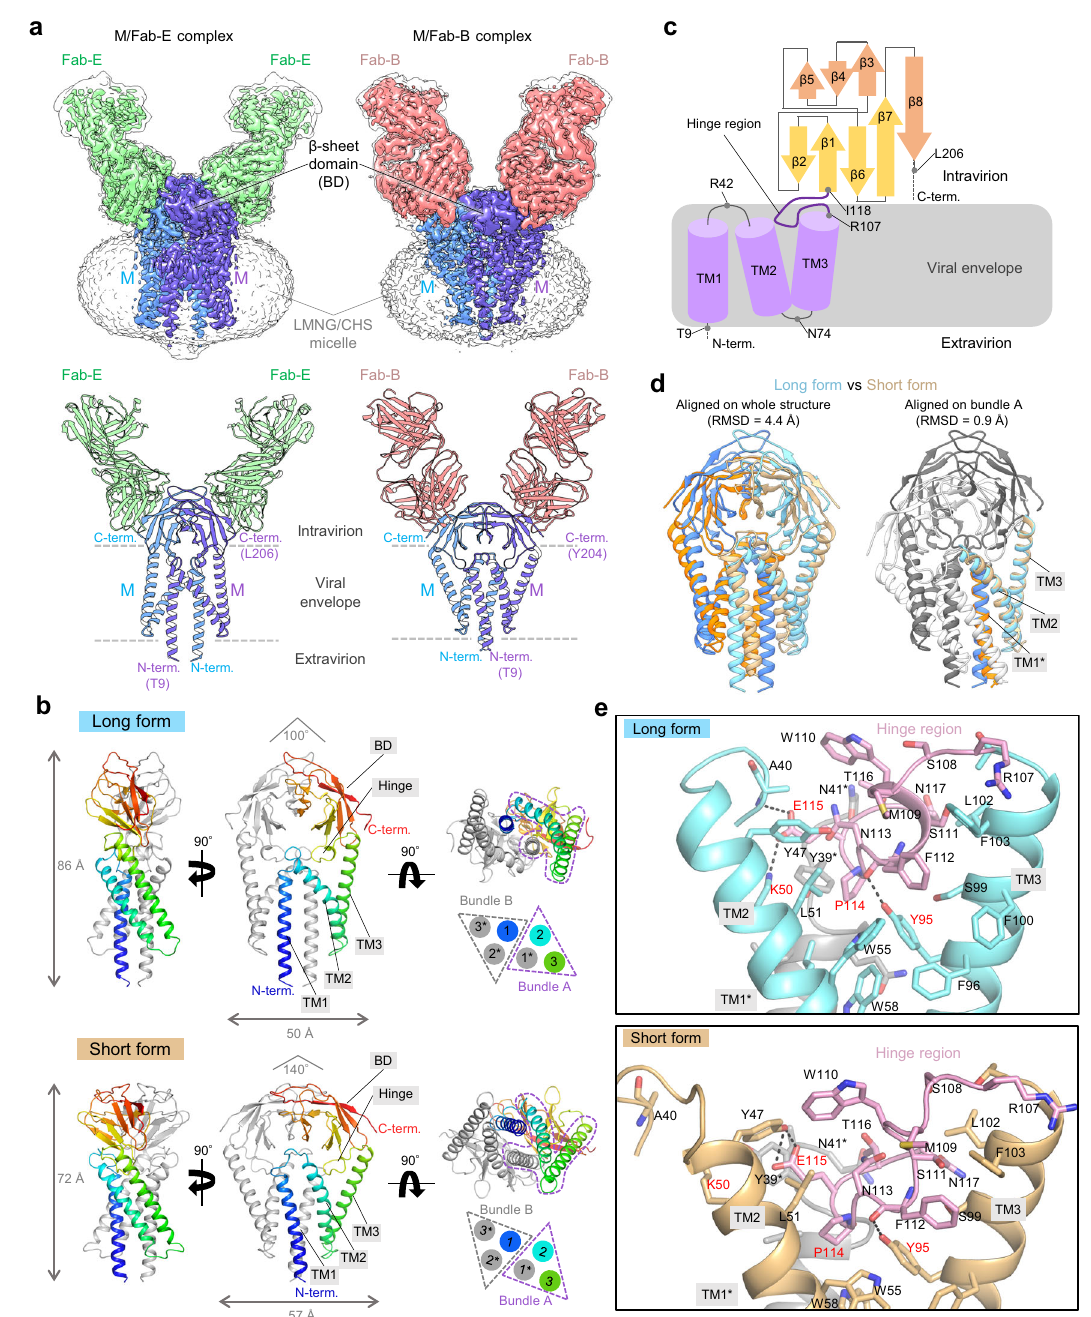
Fig. 2 | Cryo-EM structures of M protein dimer. a Cryo-EM maps (upper) and ribbon models(lower)ofM/Fab-Eand M/Fab-Bcomplexes.Unsharpened maps are shown in transparent light gray color (M/Fab-E complex: level=0.08; M/Fab-B complex: level=0.35), and B-factor-sharpened maps are show in multiple colors (M/Fab-E complex: level=0.28; M/Fab-B complex: level=0.75). M protein proto- mers, Fab-E, and Fab-B, are colored in purple, blue, green, and pink, respectively. b StructuresofMproteindimerinthelongform(upper)andtheshortform(lower) are shown from the side (left), front (middle), and bottom (right) views. One pro- tomer of M protein is colored in a rainbow, and the other is light gray. Schematic viewsofthearrangementofsixTMhelicesareshownonthelowerright.TM1*,TM2,